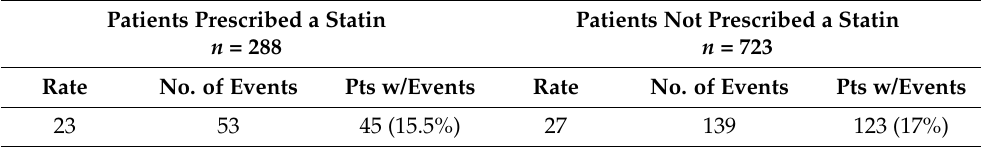
Table 8. ASCVD event rate per 1000 person-years, by statin status.